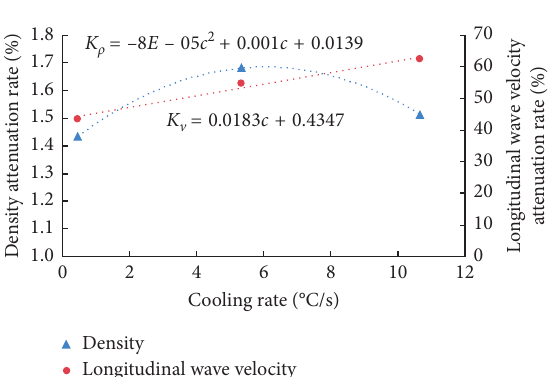
Figure 6: The relationship between the density attenuation rate, the longitudinal wave velocity attenuation rate, and the cooling rate.